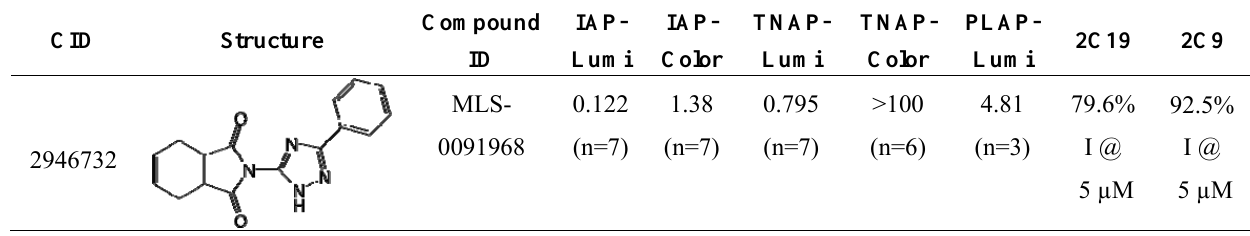
Table 8. Selectivity profile for IAP probe